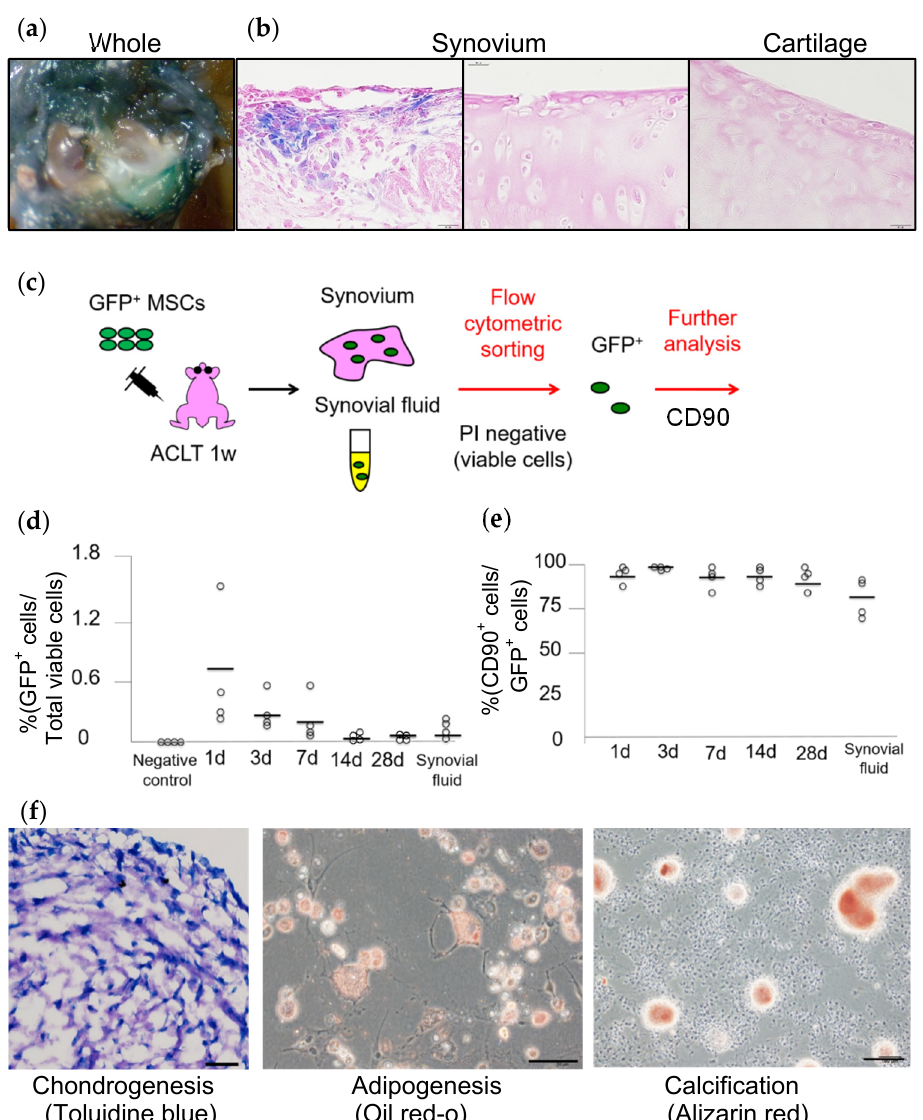
Figure 7. Distribution and properties of synovial MSCs injected into the knee. ( a ) The whole knee joint one day after injection of synovial MSCs expressing the LacZ gene into a rat knee. The ACL had been transected 7 days before. ( b ) Histological sections stained with X-gal. ( c ) Schema for the flow-cytometry assay. GFP-expressing MSCs were injected into the knees of rats 7 days after ACL transection and the synovium was harvested 1 week later. After enzymatic digestion, GFP+ cells were sorted for further analysis. PI, propidium iodide. ( d ) Ratio of GFP+ cells relative to total viable cells. ( e ) Ratio of CD90+ cells relative to total GFP+ cells. ( f ) Multi-differentiation potential of the sorted GFP+ cells 28 days after injection (reproduced from [21]).